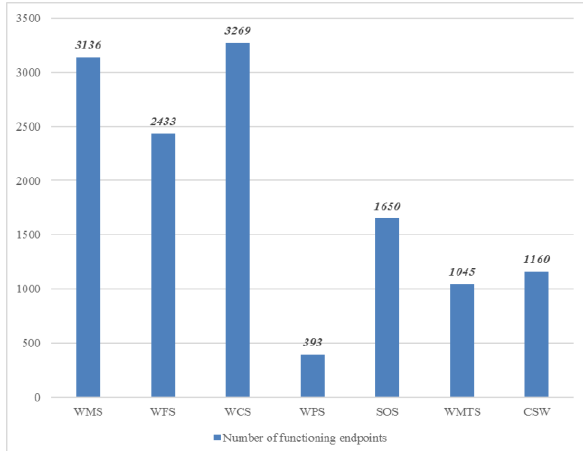
Figure 5. Number of functioning endpoints of OGC services types (valid to date 10 May 2016).